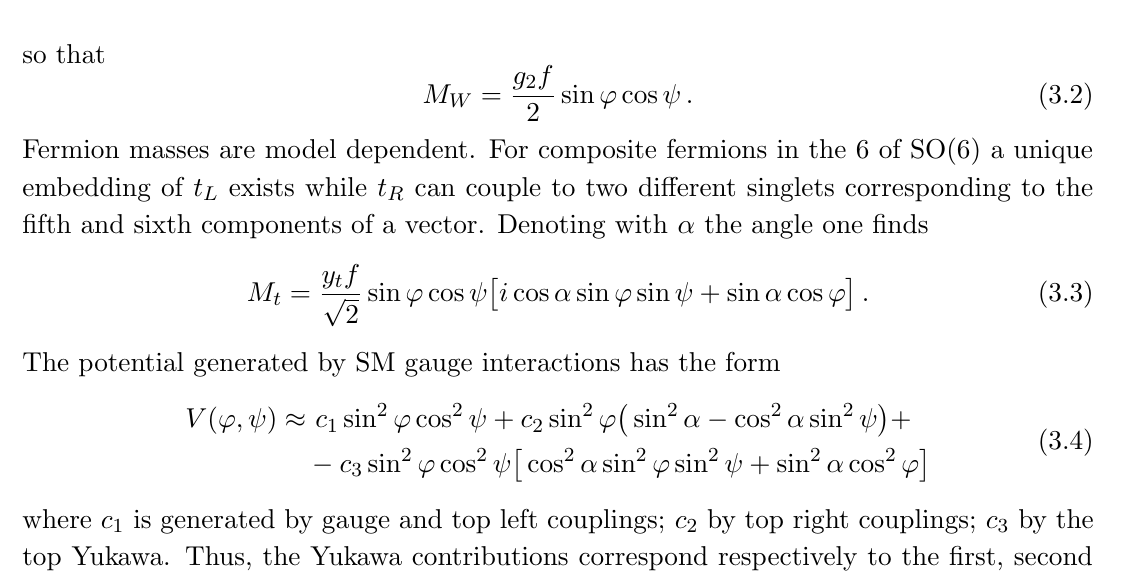
Figure 2 . The coset of the next-to-minimal composite Higgs model forms a sphere parameterized by the Higgs h and (cid:17) scalars. The h and (cid:17) directions are indicated on the North pole, which corresponds to (cid:8) = diag(0 ; 0 ; 0 ; 0 ; 0 ; f ). Contour lines of the potential V ( h; (cid:17) ) in eq. (3.4) for c i = 1 and for t R couplings (cid:11) = (cid:25)= 4 ( (cid:11) = (cid:25)= 2) in the left (right) panel. The potential increases going from blue to brown to